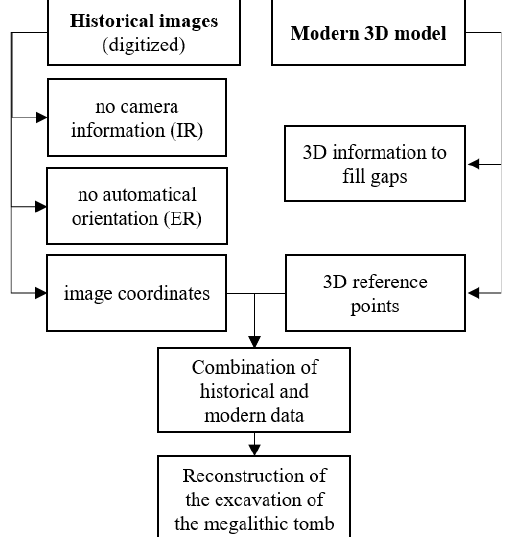
Figure 4: Concept to combine historical images with 3D data.